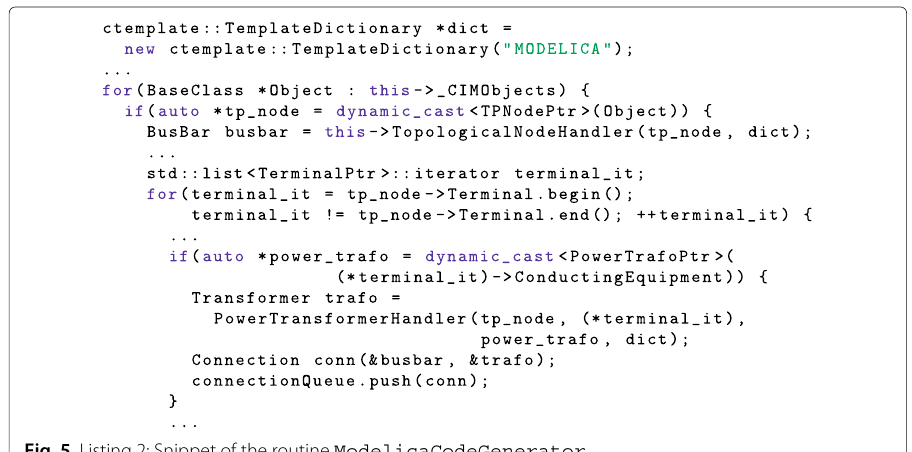
Fig. 5 Listing 2: Snippet of the routine ModelicaCodeGenerator